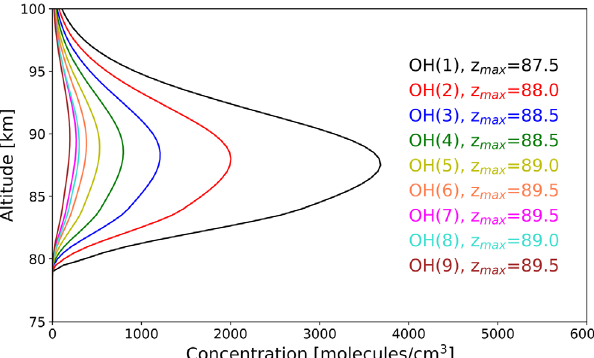
Fig. 3. Examples of OH vibrational states concentration as function of